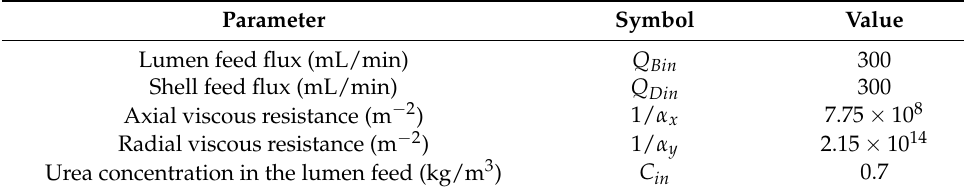
Table 4. Parameters considered constant in the GCI analysis.